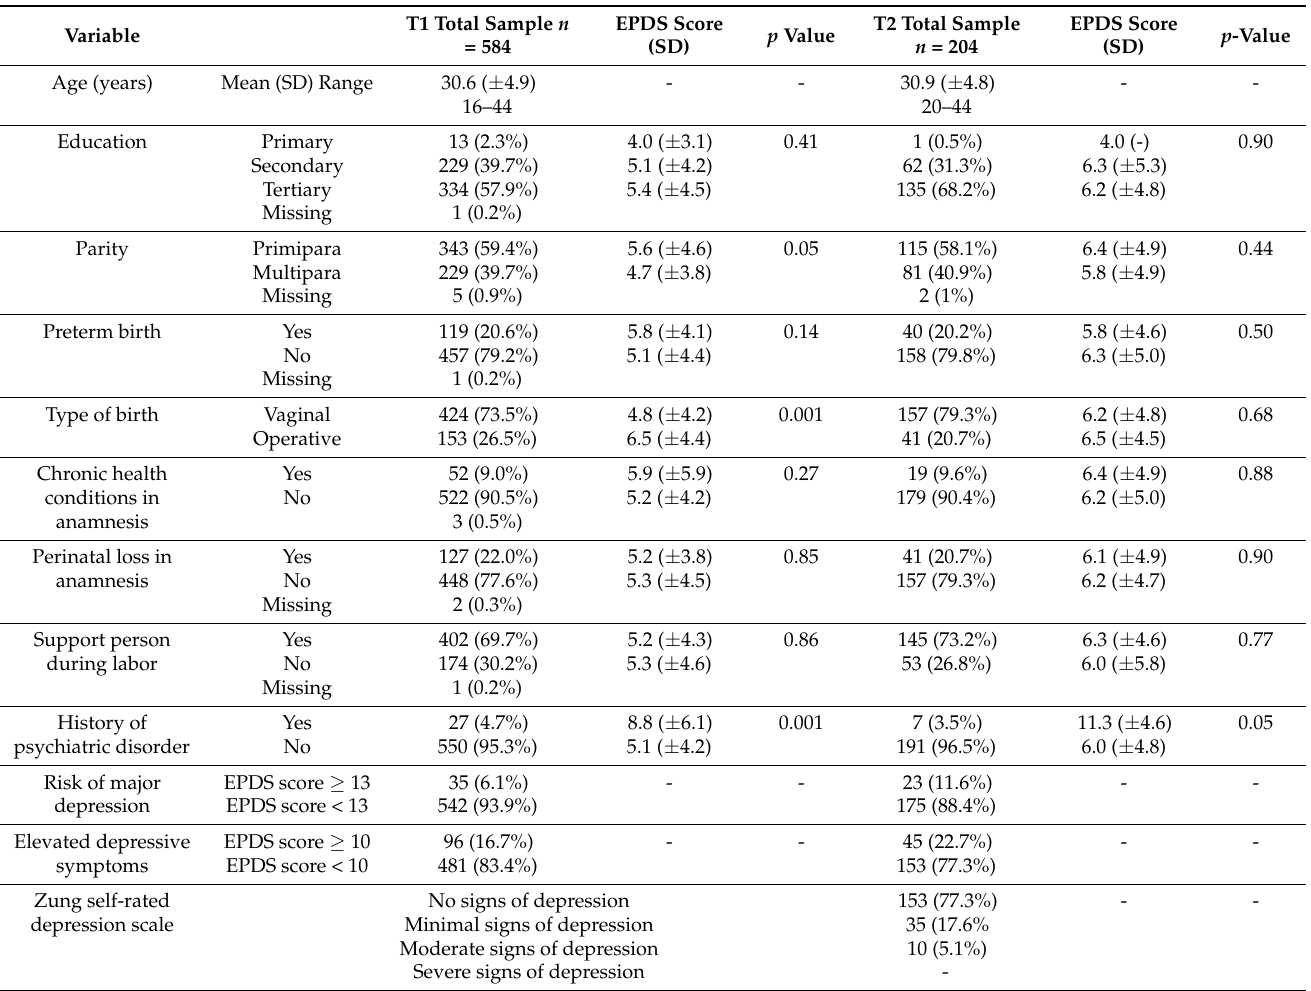
Table 1. Characteristics of the study